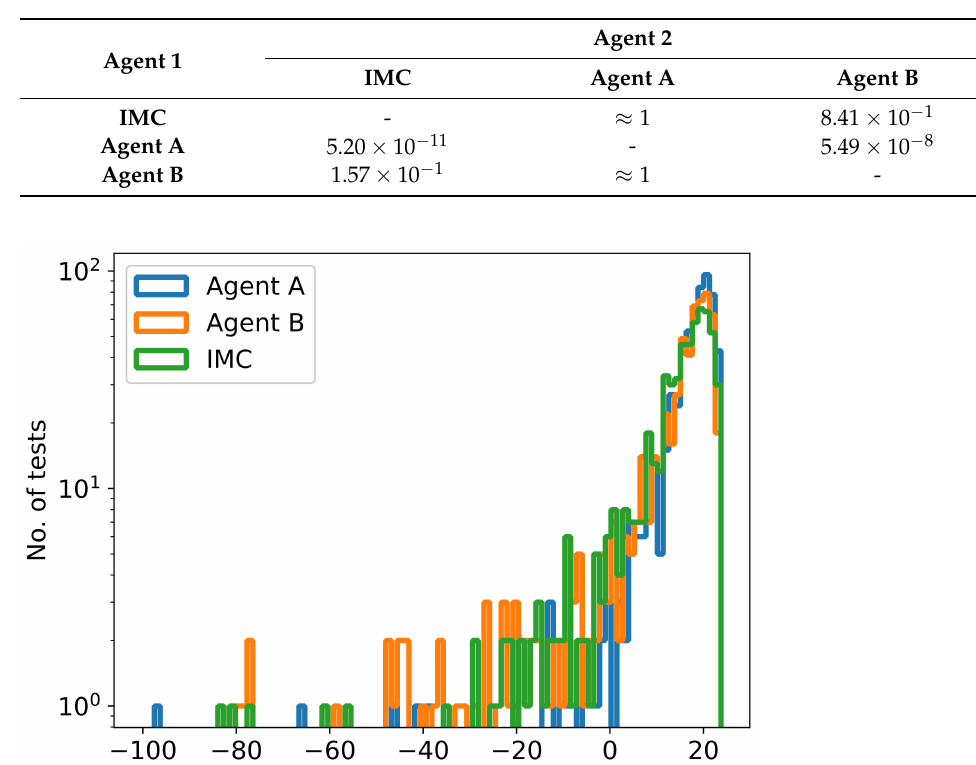
Table 4. Mann–Whitney rank test p -values for the null hypothesis that agent “1” (rows) achieves lower or equivalent cumulative rewards than agent “2” (columns). The null hypothesis is rejected when p < 0.05.